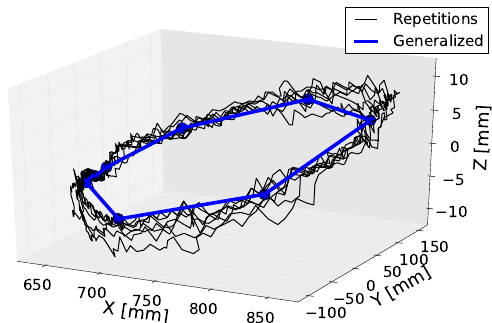
Figure 2. Plot of a three-feature action generalization. Black lines depict the demonstrations. The blue line is the generalized action obtained from all the